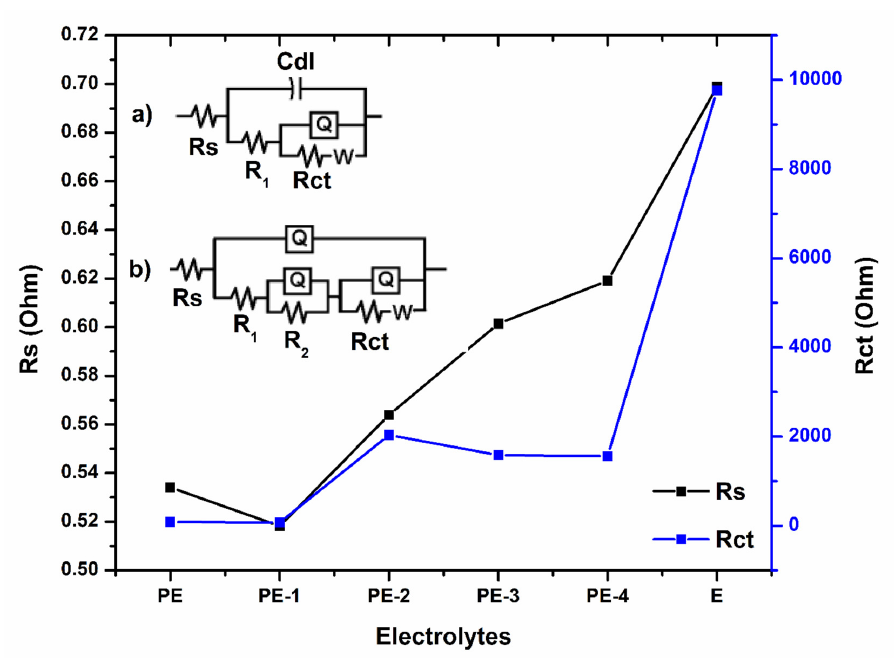
Figure 7. Equivalent circuits of ( a ) developed polymer gel electrolyte ( b ) 36 wt% H 2 SO 4 and Solution resistance (Rs) and charge transfer resistance (Rct) of plane PVA (PE), PVA − 20 wt% TEOS (PE − 1), PVA − 40 wt% TEOS (PE − 2), PVA − 60 wt% TEOS (PE − 3), PVA − 80 wt% TEOS (PE − 4) and 36 wt% H 2 SO 4 (E).